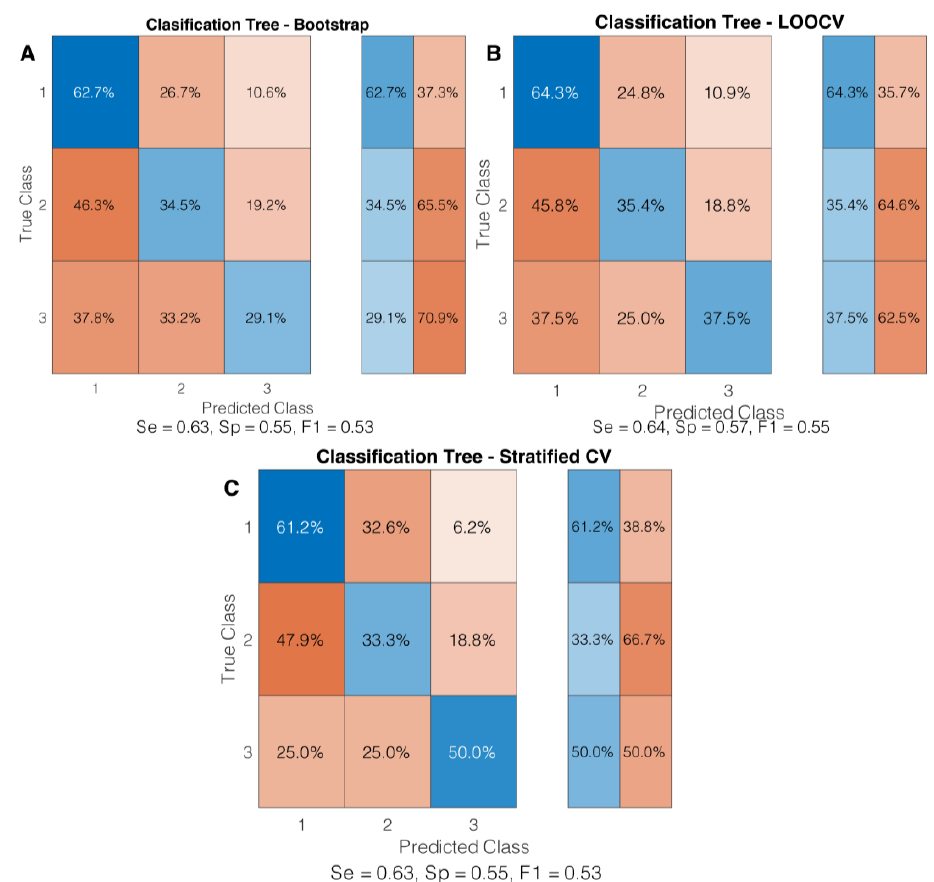
Figure 6. Confusion matrices for tree ensemble classification trees with different types of cross-val- idation. ( A ) Shows bootstrap CV, ( B ) shows leave-one-out CV and ( C ) shows stratified CV.